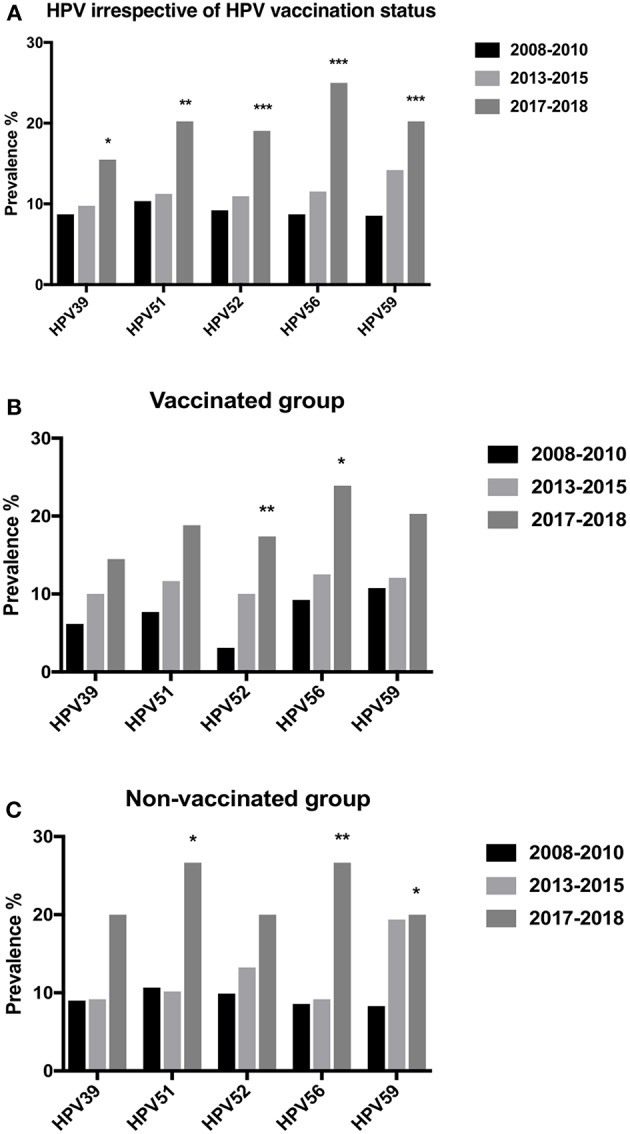
Prevalence of specific human papillomavirus (HPV) types over the years 2008–2018. (A) Cervical prevalence of HPV39, 51, 52, 56, and 59 irrespective of vaccination status over the years 2008–2010, 2013–2015, and 2017–2018. (B) Cervical prevalence of HPV39, 51, 52, 56, and 59 in vaccinated women over the years 2008–2010, 2013–2015, and 2017–2018. (C) Cervical prevalence of HPV39, 51, 52, 56, and 59 in non-vaccinated women over the years 2008–2010, 2013–2015, and 2017–2018. *p < 0.05, **p < 0.01, ***p < 0.001.